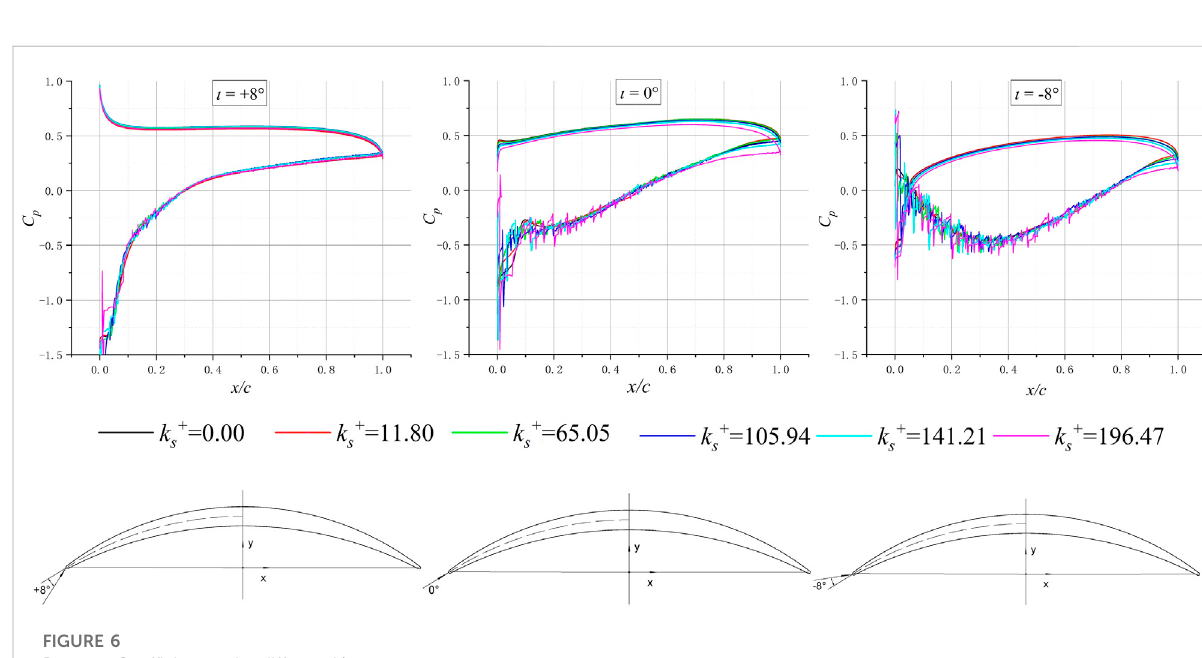
FIGURE 6 Pressure Coef fi cient under different. k +